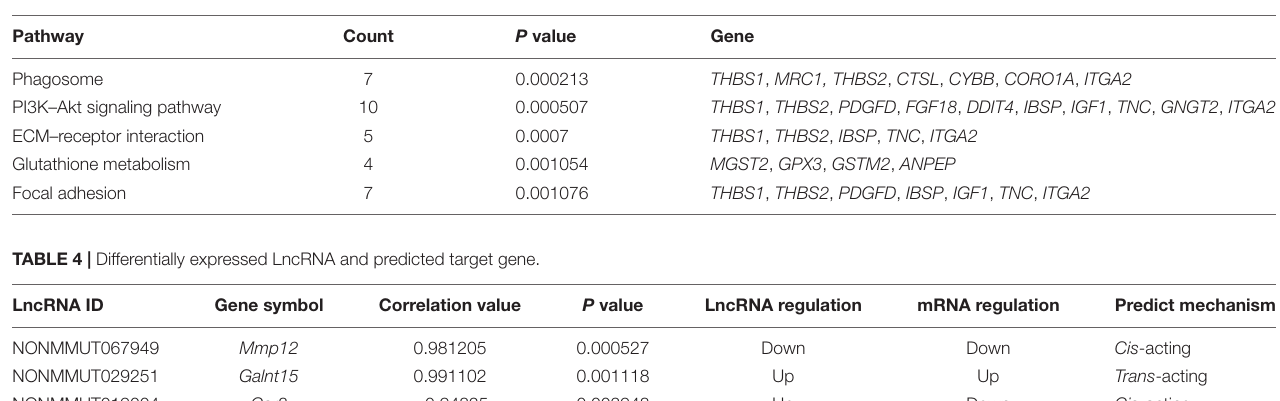
TABLE 3 | Top 5 pathways with largest significant difference in KEGG analysis.